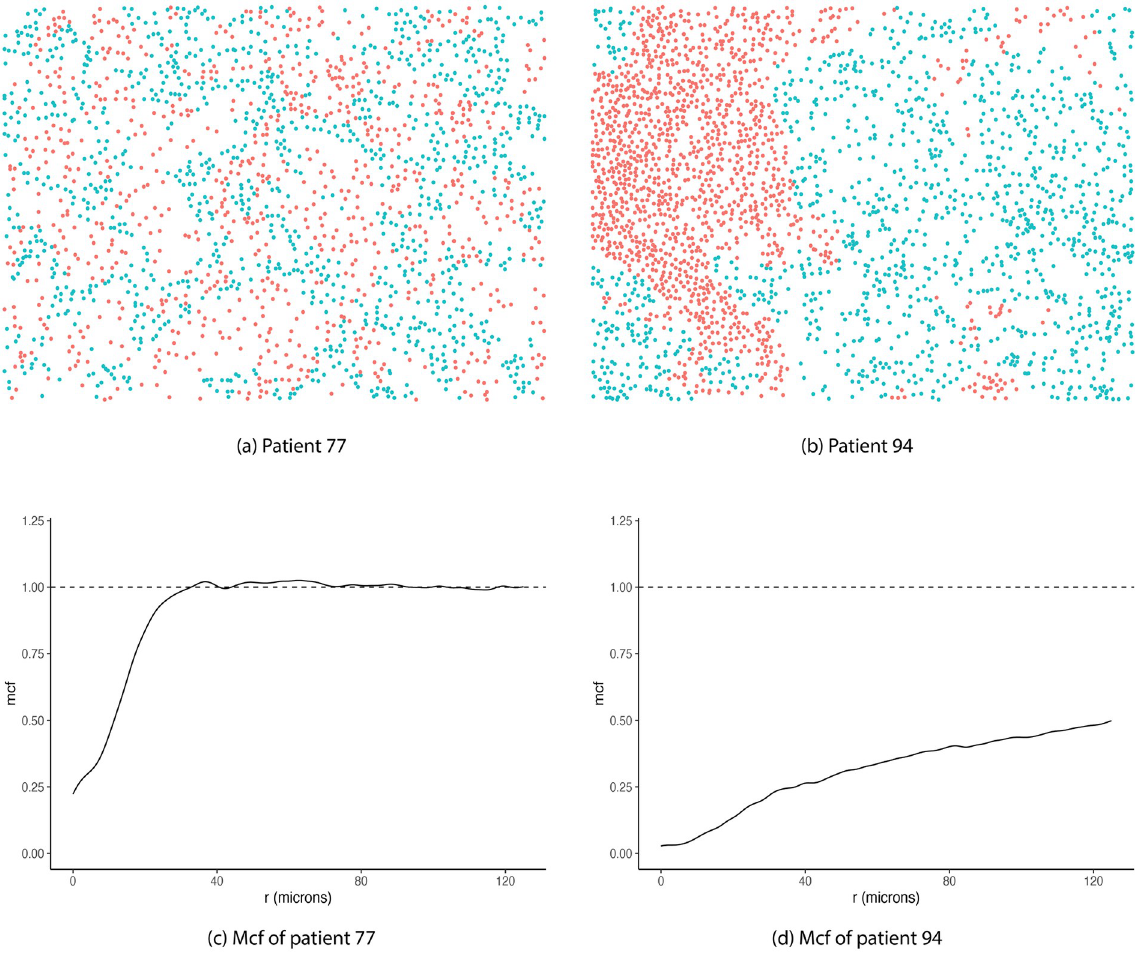
Fig 1. Examples of mark connection functions (mcf). Tumor (turquoise) and stromal (red) cell distributions of two patients’ images: (A) 77 and (B) 94, respectively. Corresponding mcf curves are shown in (C) and (D), respectively. Dashed horizontal lines representing mcf under complete randomness. Mcf values below 1 indicate strong clustering of cells of same type, while values above 1 suggest higher level of mixing in of the two cell